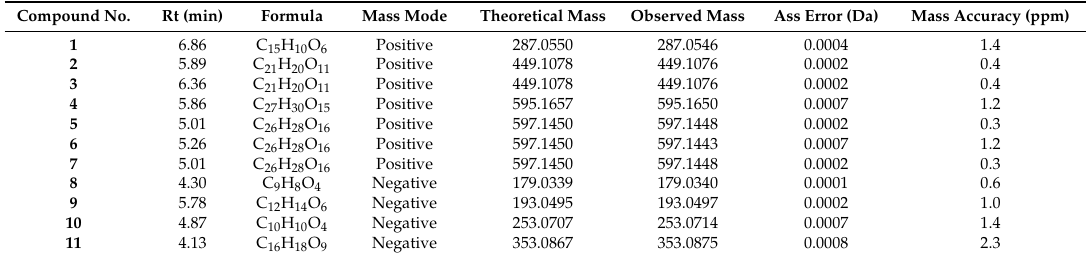
Table 3. IC 50 of the compounds 1 – 11 from T. coreanum on advanced glycation end-product (AGE) formation and α -glucosidase inhibitory